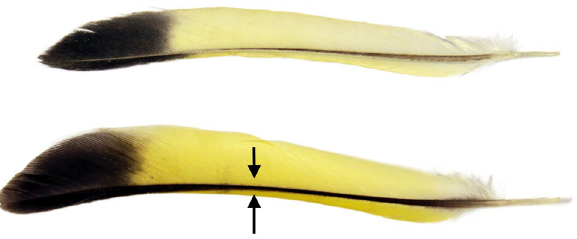
Figure 2. Measurement of feather chroma. The arrows indicate positions where chroma of yellow feather coloration was measured. Upper – lab-grown feather, lower – wild-grown